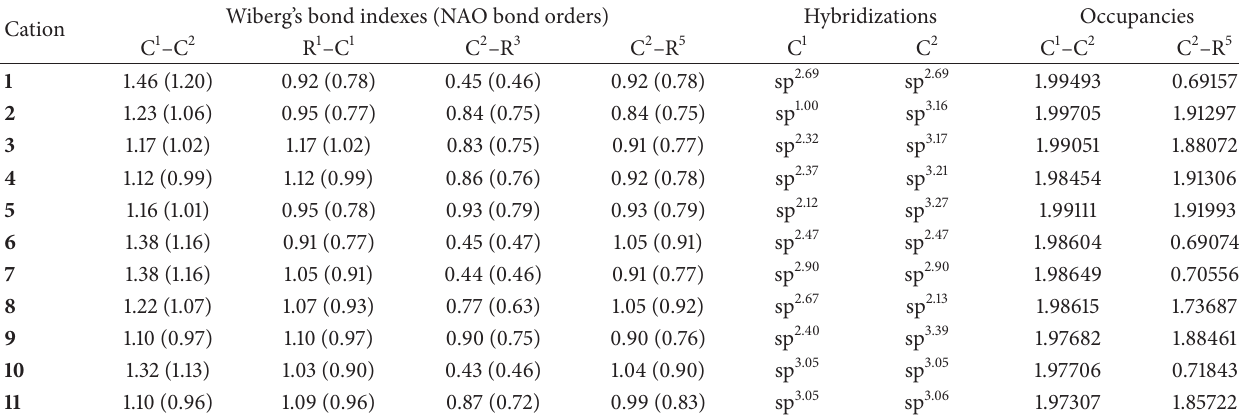
Table 4: Bond orders, bond indexes, hybridizations, and occupancies parameters for multisubstituted ethyl cations 1 – 11 . Cation